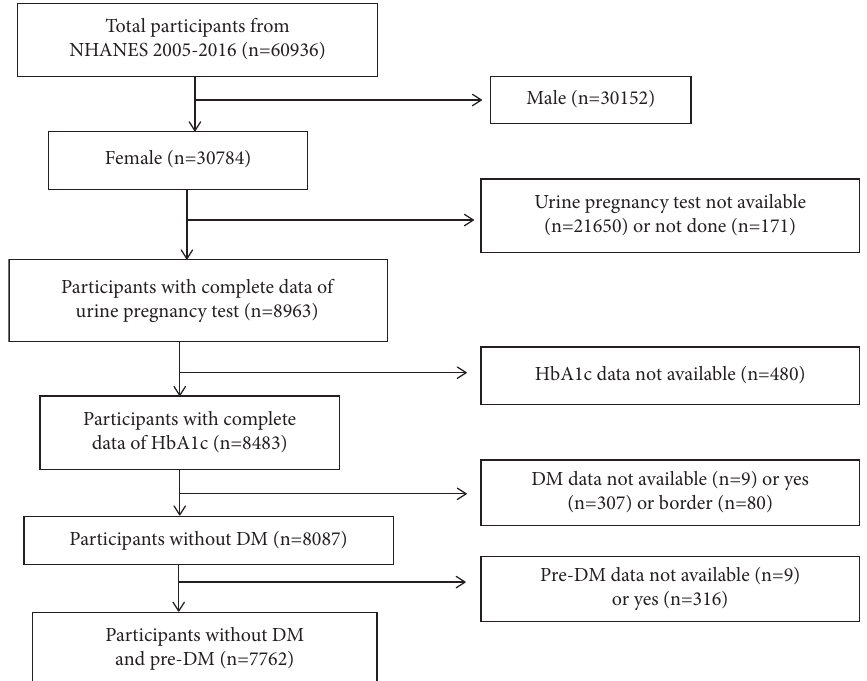
Figure 1: Flow chart of sample selection from the NHANES